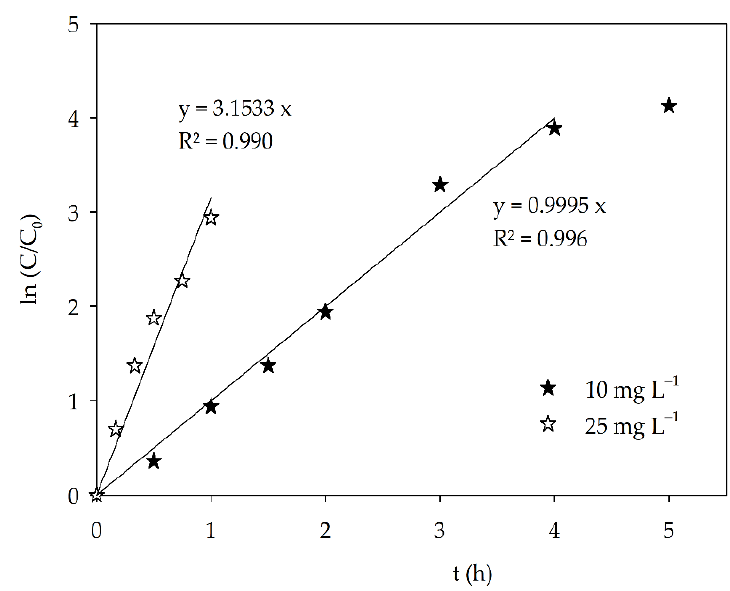
Figure 7. Pseudo-first-order kinetics for AO7 degradation under visible light over Sr 0.95 Bi 0.05 TiO 3.